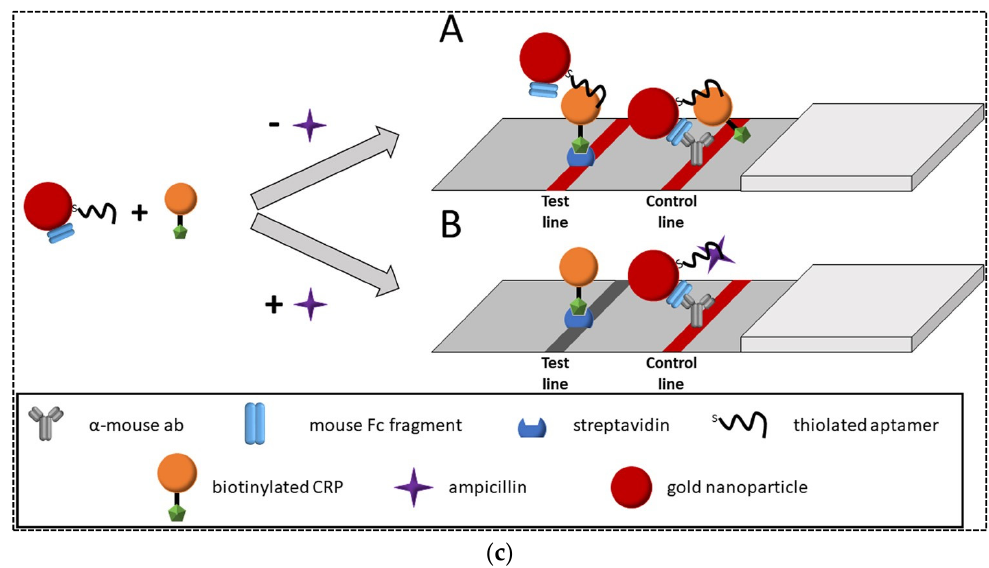
Figure 6. ( a ) Schematic representation of magnetic microsphere-assisted LFA for kanamycin detection; ( b ) A competitive aptamer-based LFA for the detection of oxytetracycline; ( c ) A competitive aptamer-based LFA for ampicillin detection. Reprinted from [62–64] , respectively, with permission.